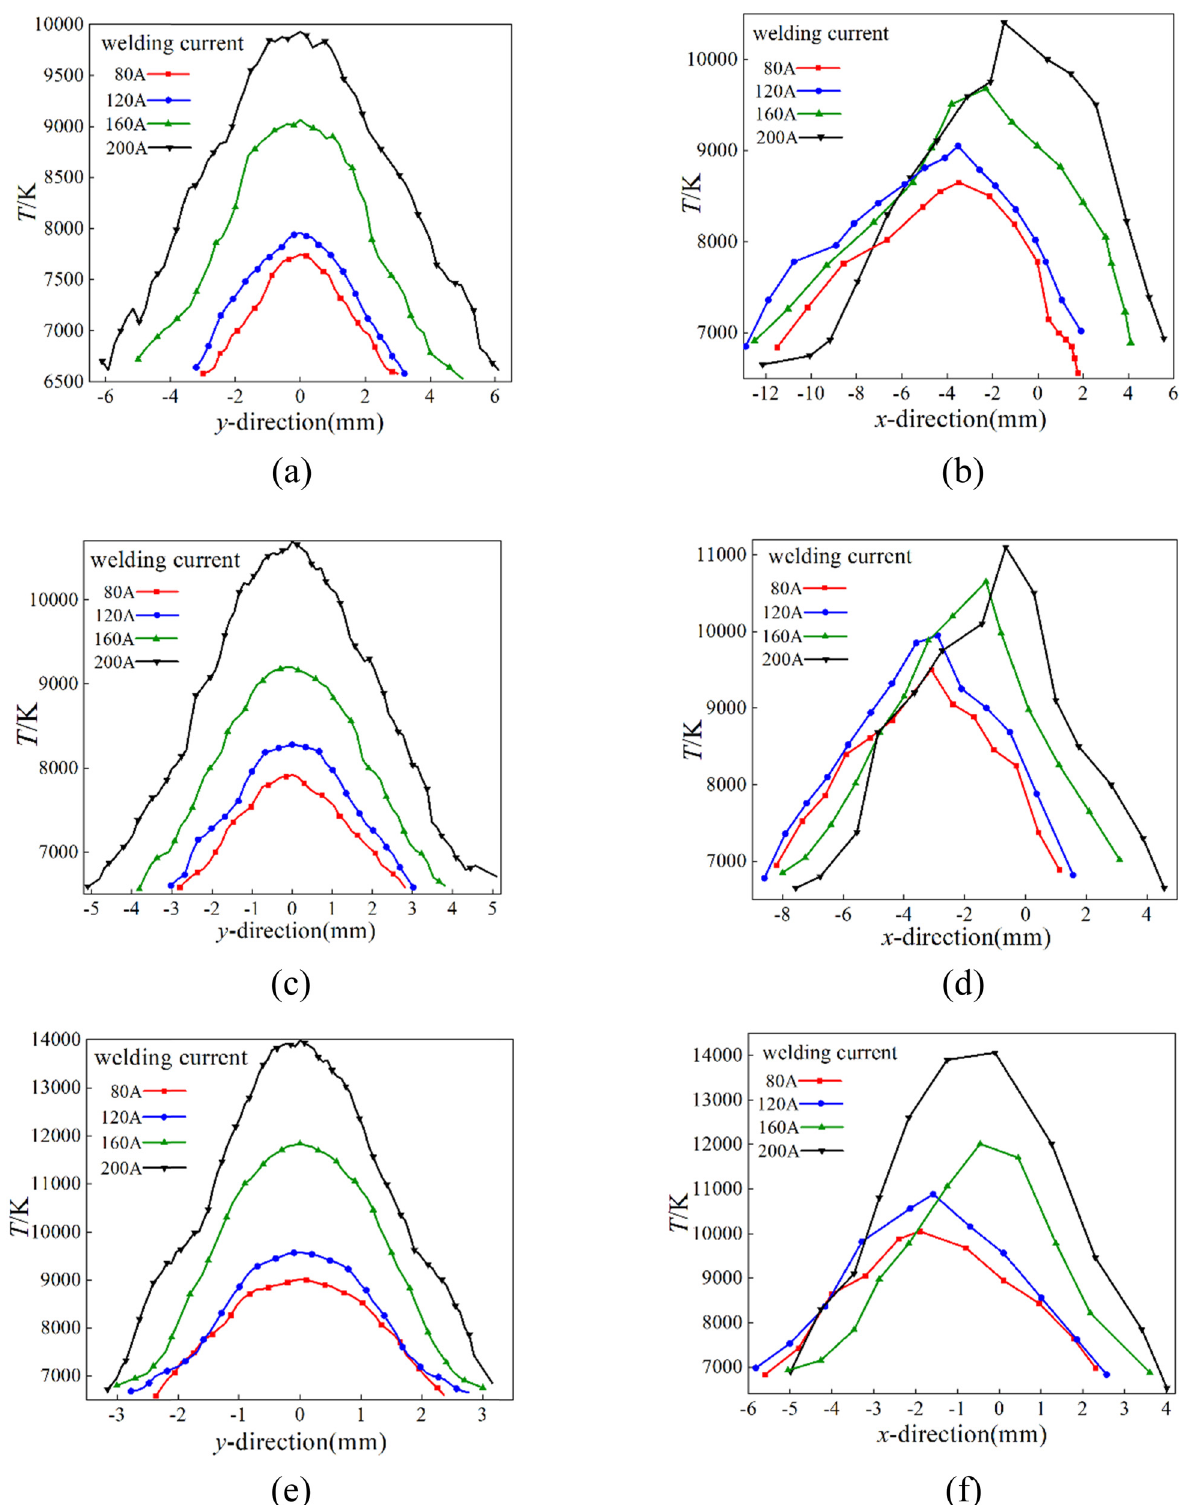
Figure 9: T distribution of arc current - carrying region with di ff erent welding current. ( a ) T distribution in y - direction, z = 1 mm. ( b ) T distribution in x - direction, z = 1 mm. ( c ) T distribution in y - direction, z = 2.5 mm. ( d ) T distribution in x - direction, z = 2.5 mm. ( e ) T distribution in y - direction, z = 4 mm. ( f ) T distribution in x - direction, z = 4